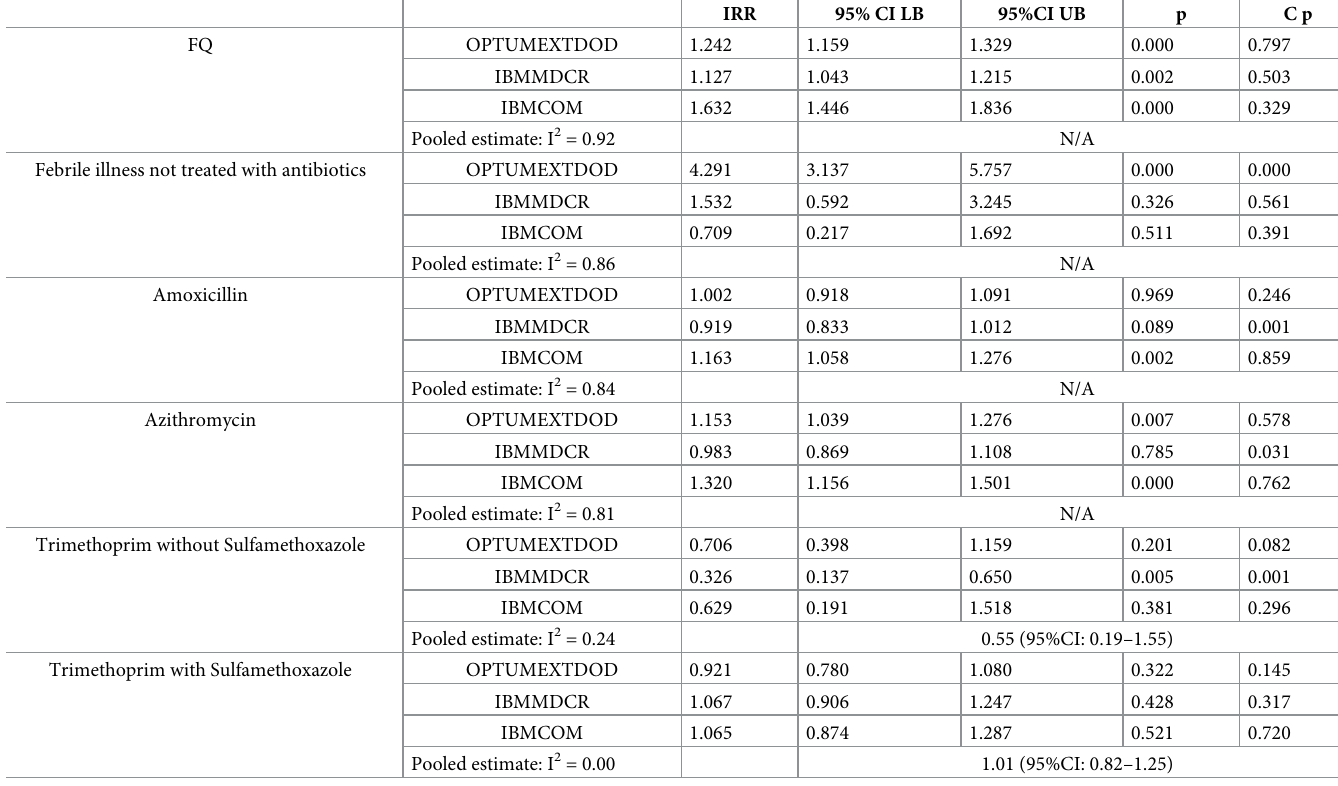
Table 3. IRR with 95% confidence intervals and calibrated p values for AAD and following each exposure as indicated, for each of the databases, adjusted for age and